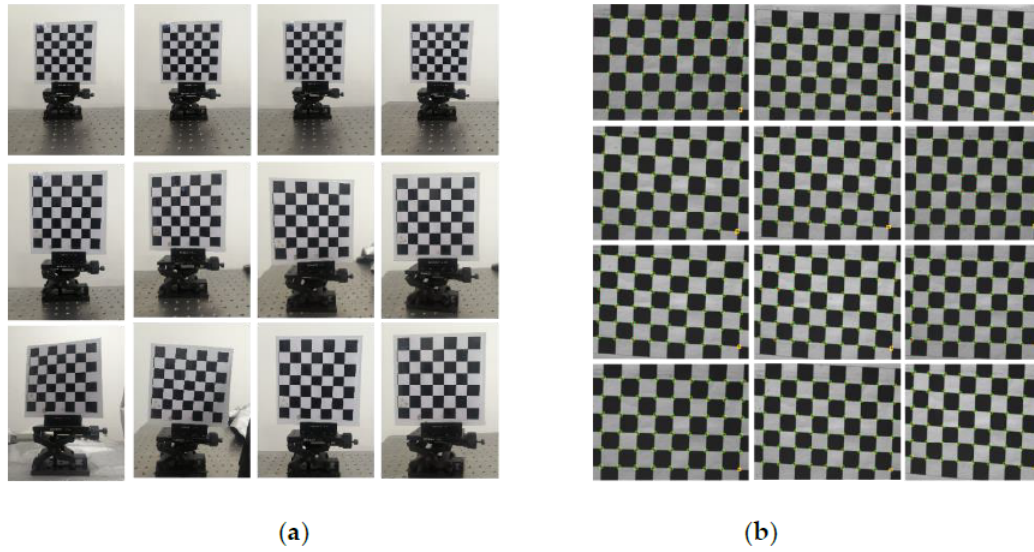
Figure 6. Camera calibration process in the air and some corner points extraction results. ( a ) Twelve Calibration boards with different attitude; ( b ) Corner extraction results of image.